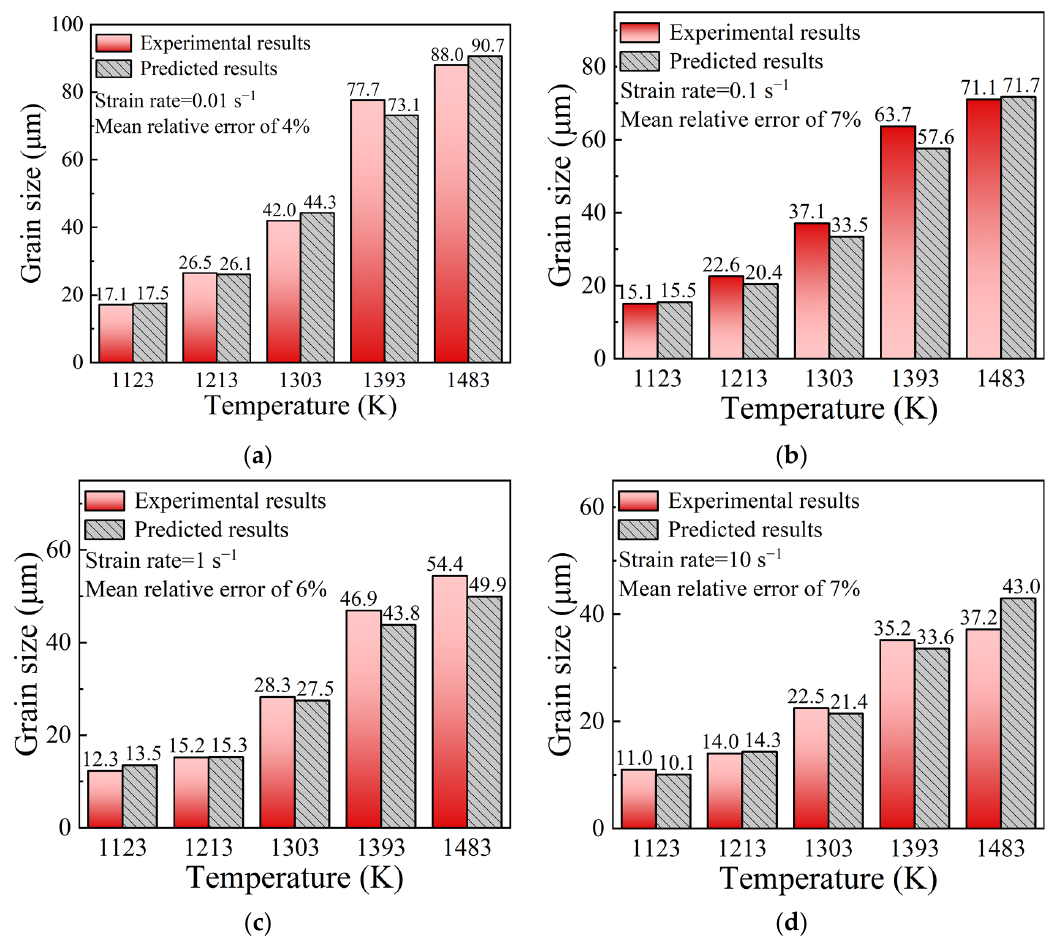
Figure 23. Comparisons of grain size between experimental results and predicted ones from CA models under temperatures of 1123–1483 K and different strain rates: ( a ) 0.01 s − 1 , ( b ) 0.1 s − 1 , ( c ) 1 s − 1 , ( d ) 10 s − 1 .